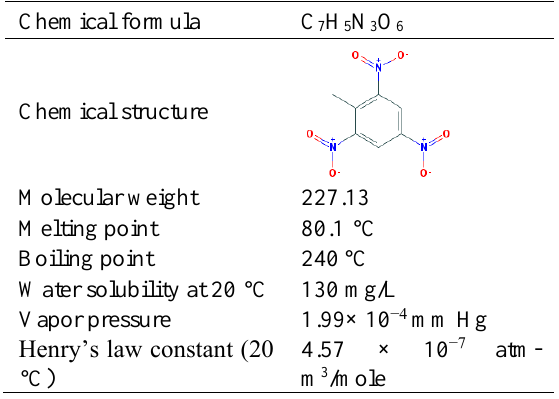
Table 1. Physicochemical properties of